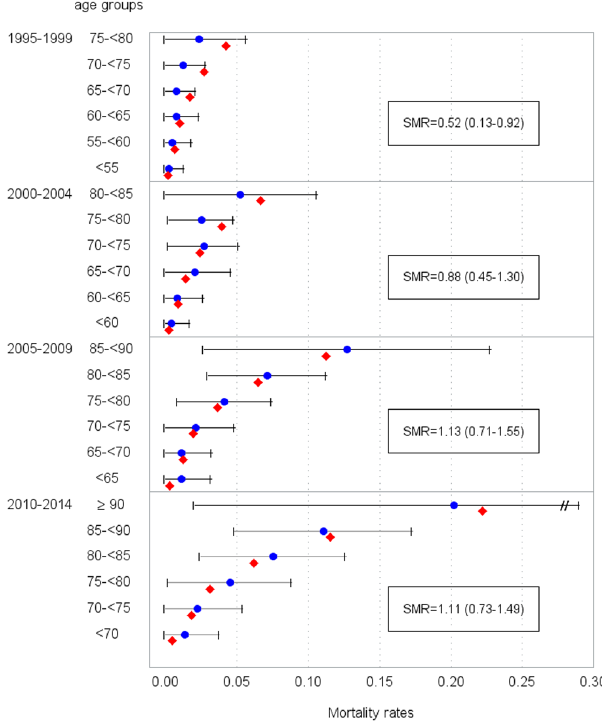
Figure 2. Age-specific mortality in 5-year periods after arthroplasty in the study cohort ( ) (baseline recruitment Jan. 1995 until Dec. 1996) and general population ( ). SMR standardized mortality